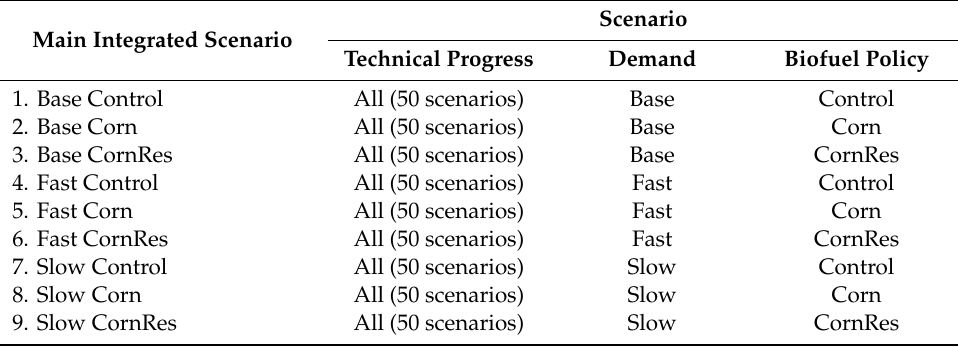
Table 3. Main integrated scenario specifications.